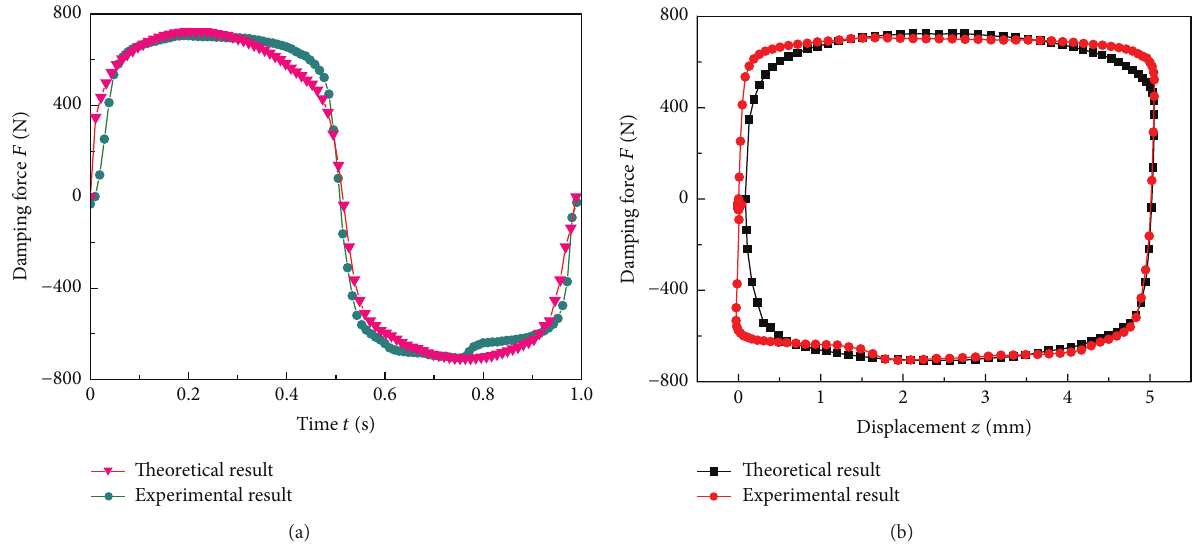
Figure 13: Comparison between theoretical result and experimental data: (a) damping force versus time and (b) damping force versus displacement.